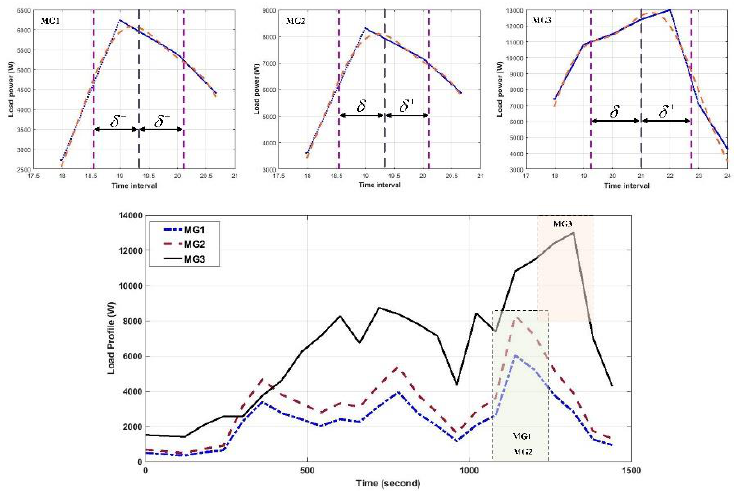
Figure 3. Power management algorithm for the HIMG.